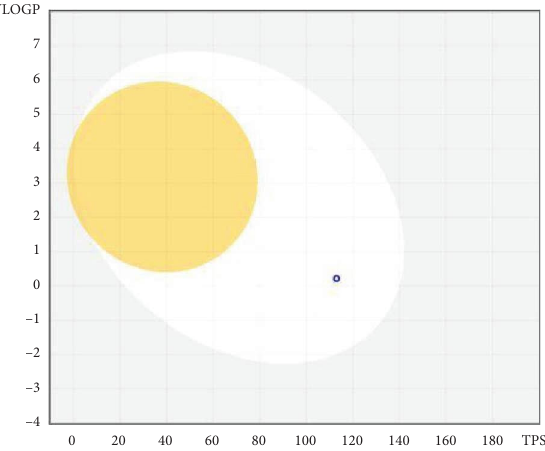
Figure 5: Boiled graph representation of C4.